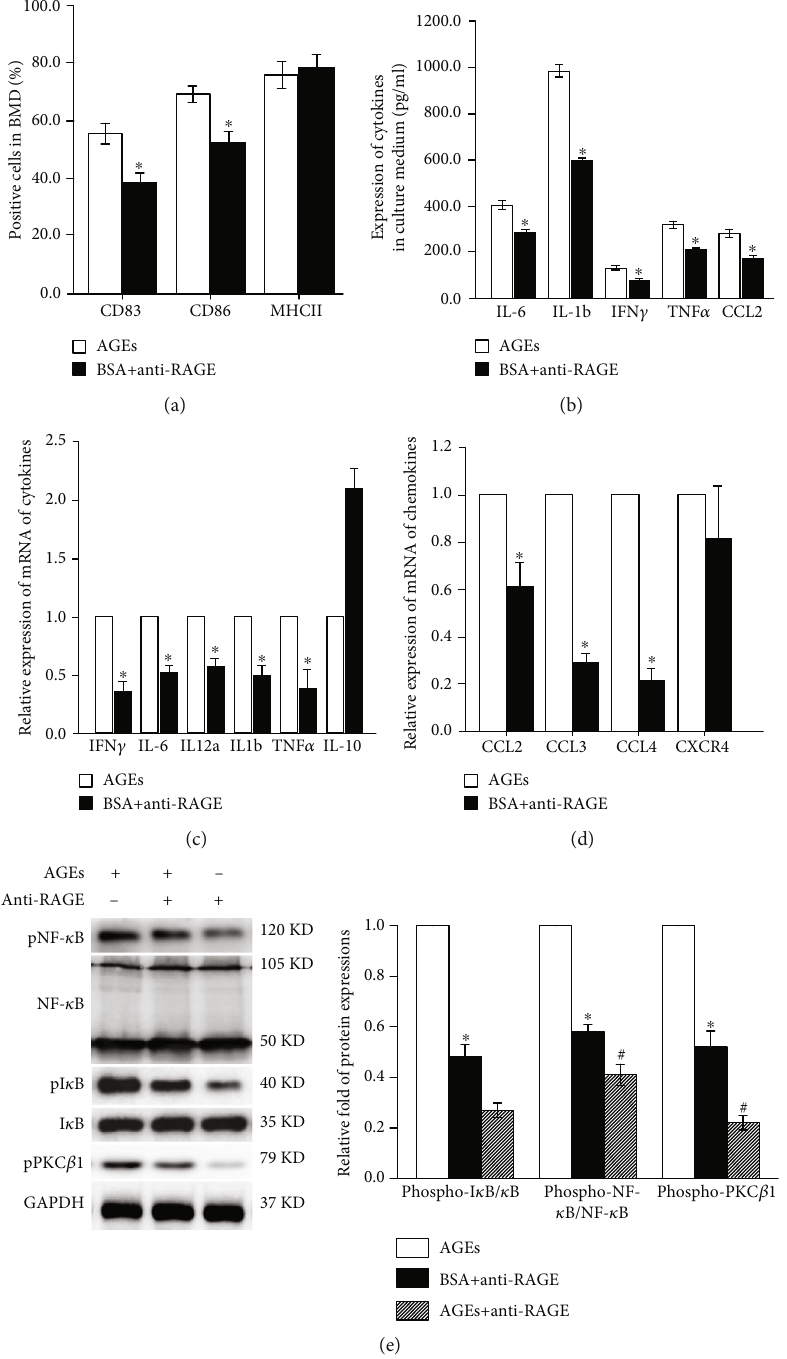
Figure 4: RoleofRAGEintheAGEs-BSA-stimulatedBMDCsimmunematuration.(a)Flowcytometricanalysiswasperformedforcellsurface CD83, CD86, and MHC-II expression examinations. RAGE neutralizing antibody attenuated AGEs-BSA-induced upregulation of CD83 and CD86. (b) The concentrations of TNF- α , IFN- γ , IL-6, IL-1b, and CCL2 in the supernatants of the culture were measured by ELISA; (c, d) The expressions of cytokines and chemokines mRNA in BMDCs were analyzed by real-time quantitative RT-PCR. Secretion of cytokines and chemotactic factors was all reversed by RAGE neutralizing antibody; (e) The expressions of NF- κ B, I κ B, and phosphorylated PKC β 1 were determined by western blot in the presence or absence of anti-RAGE neutralizing antibody. The phosphorylation of I κ B, NF- κ B, and PKC β 1 induced by AGEs-BSA decreased after treated with anti-RAGE neutralizing antibody. Besides, anti-RAGE neutralizing antibody also inhibit the phosphorylation of I κ B, NF- κ B, and PKC β 1 without AGEs-BSA. Data are expressed as mean ± SED ; n = 5 ; ∗ p < 0 : 05 vs. control group; # p < 0 : 05 vs. AGEs-BSA group. AGEs-BSA: advanced glycosylation end-bovine serum albumin; BMDCs: bone marrow- derived dendritic cells; RAGE: receptor for advanced glycation end products; pPKC: phosphorylated protein kinase C; TNF- α : tumor necrosis factor- α ; IFN- γ : interferon- γ ; MHC-II: major histocompatibility complex-II; NF- κ B: nuclear factor- κ